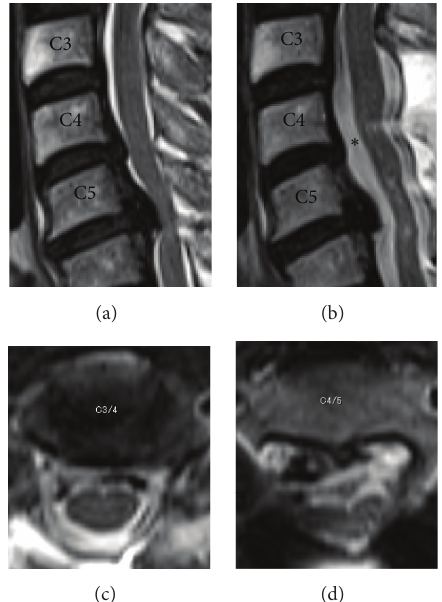
Figure 5: Pre- and postoperative magnetic resonance imaging. (a) and (b): posterior shift of the spinal cord at C4/5 ( ∗ ) was 3.8 mm. (c) and (d): sufficient decompression of the spinal cord was achieved and high-intensity areas in the spinal cord at C3/4 were not detected.